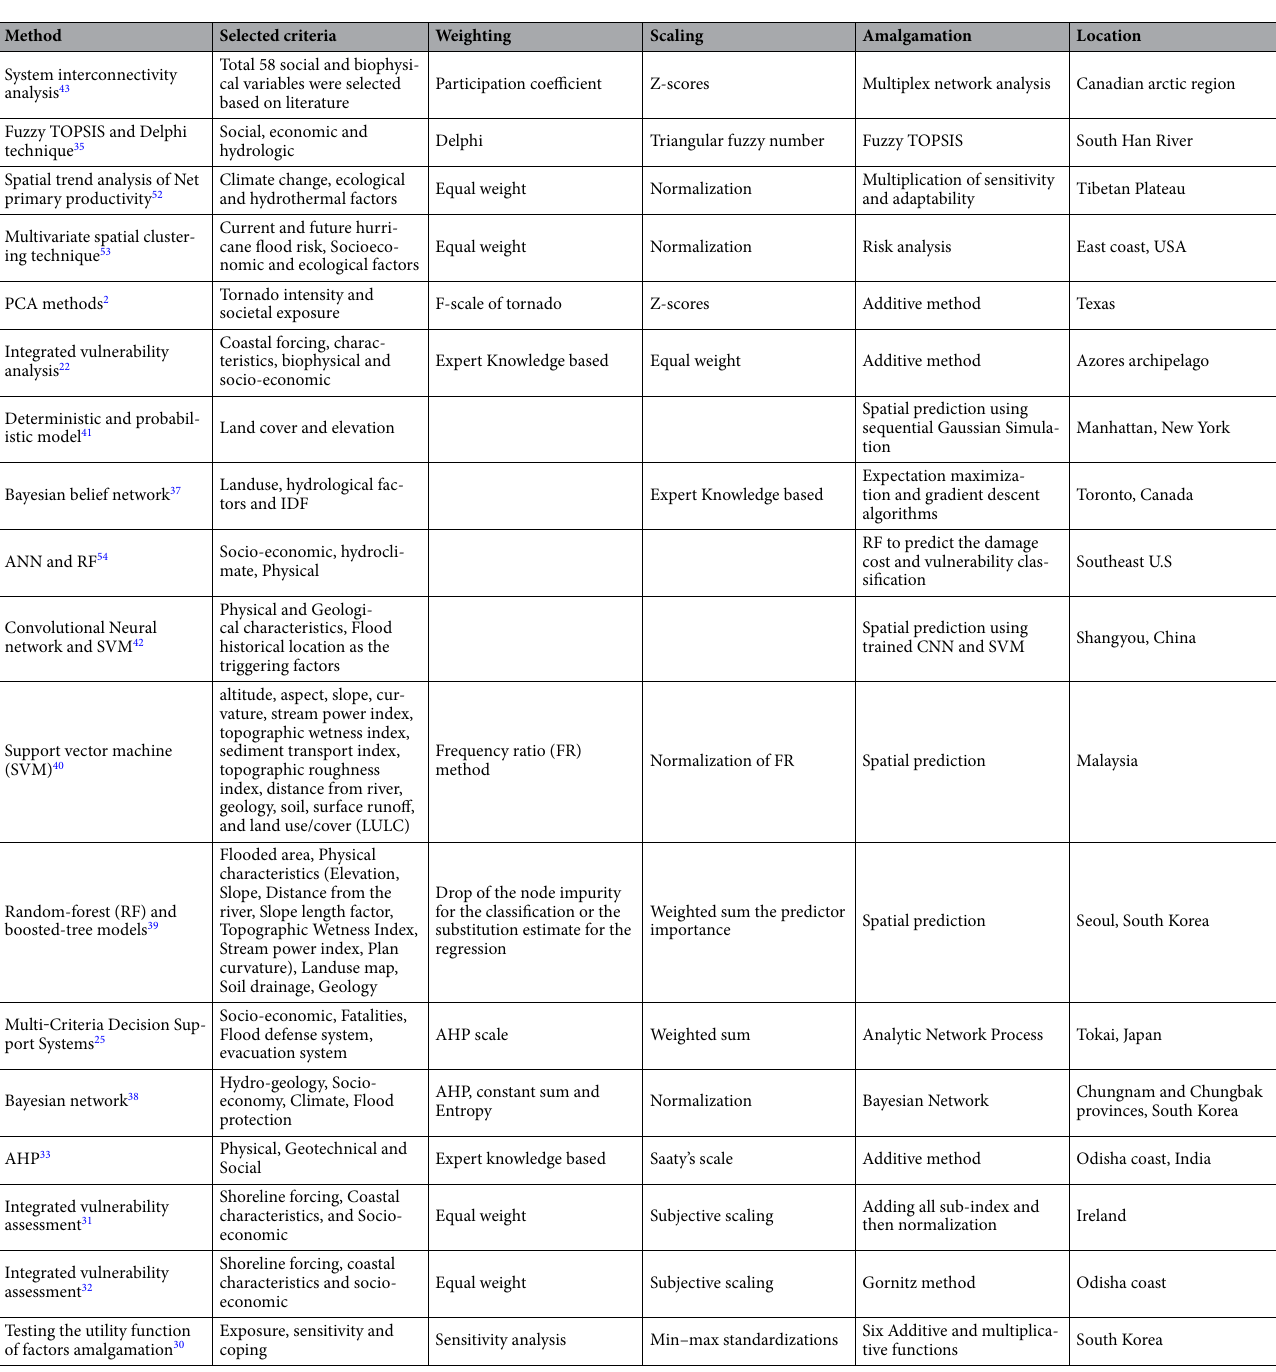
Table 1. Summary of literature review for the vulnerability analysis of natural